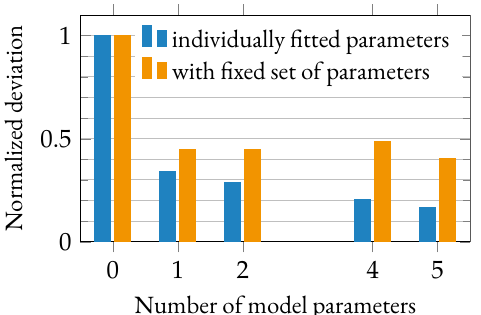
Figure 11. Total deviation between the numerical data and the Jeffery model (no parameter), the FT model (1 parameter), the Reduced Strain Closure (RSC) model (2 parameters), the MOldflow Rota- tional Diffusion (MRD) model (4 parameter) and the Anisotropic Rotary Diffusion (ARD) model (5 parameters). The total deviation is normalized by the deviation of the Jeffery